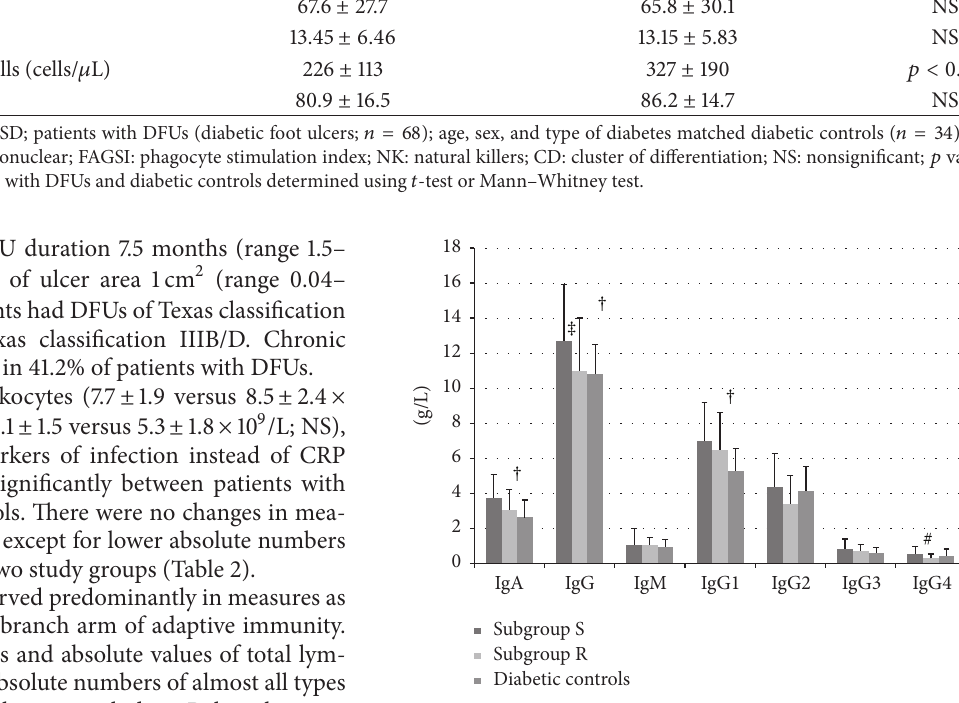
Figure 1: The comparison of serum levels of immunoglobu- lins including IgG subclasses among patients with chronic DFUs infected by sensitive and resistant pathogens and diabetic controls. Data are presented as means ± SD; patients with DFUs (diabetic foot ulcers) infected by sensitive (subgroup S; 𝑛 = 50 ) or resistant pathogens (subgroup R; 𝑛 = 18 ). Age, sex, and type of diabetes matched diabetic controls ( 𝑛 = 34 ); Ig: immunoglobulin; 𝑝 value of significance between patients with DFUs infected by sensitive (subgroup S) or resistant pathogens (subgroup R) and diabetic controls determined using Kruskal-Wallis one way analysis of variance test. † 𝑝 < 0.01 : mean serum levels of IgA, IgG, and IgG1 in subgroup S versus diabetic controls. ‡ 𝑝 < 0.05 : mean serum levels of IgG in subgroup S versus subgroup R. # 𝑝 < 0.01 : mean serum levels of IgG4 in subgroup S versus subgroup